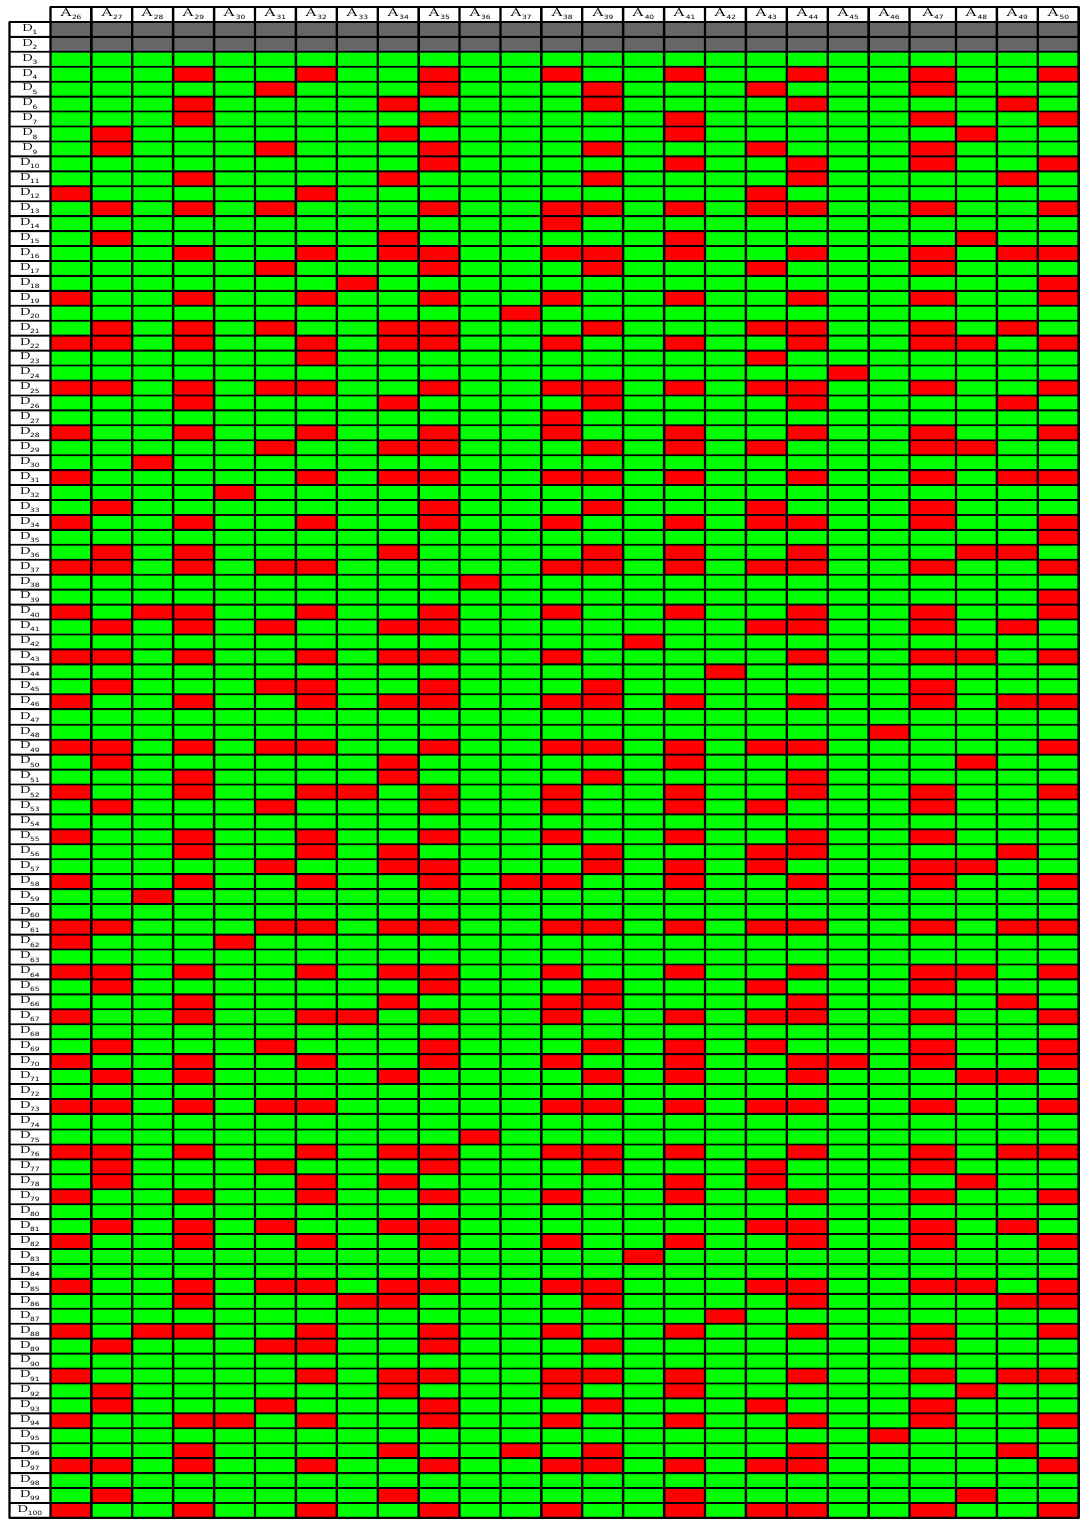
Table 7 . Analyzed theories for ( D n ; A m ) with n = 3 ; : : : 100 and m = 26 ; : : : 50.